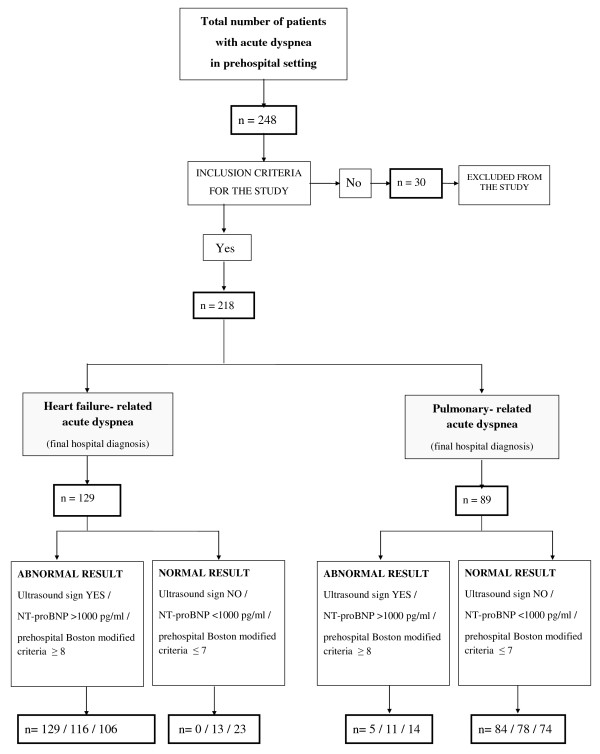
Flow diagram illustrating recruitment, exclusion and subsequent grouping of all patients in the study. NT-proBNP, N-terminal pro-brain natriuretic peptide.